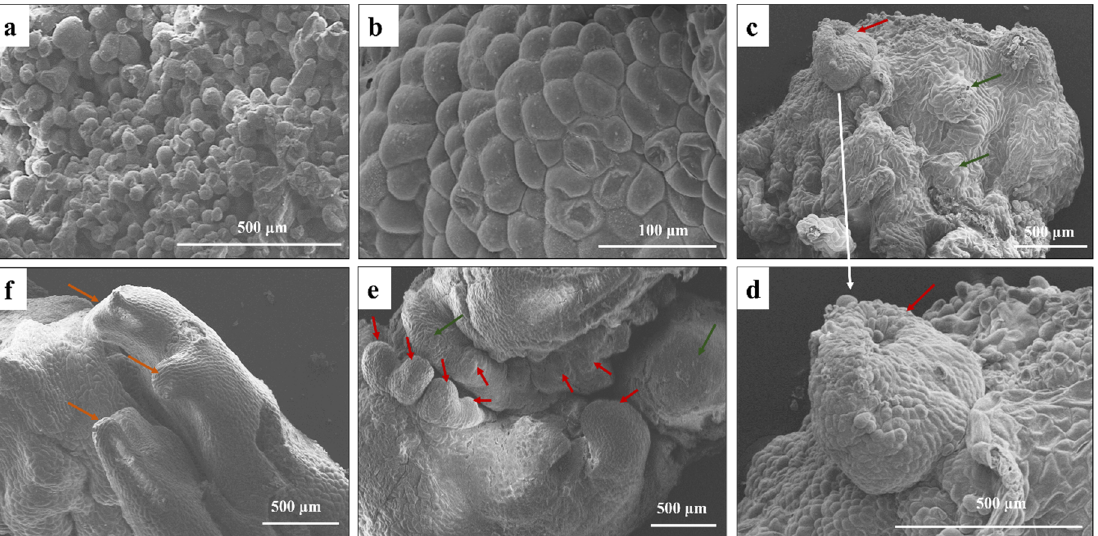
Figure 2. Scanning electron microscope (SEM) observation of shoot regeneration process. ( a ) Non- embryonic callus (S1), ( b ) Embryonic callus (S2), ( c – e ). Somatic embryos (S3) with established SAMs, ( f ) The regenerated shoots (S4). Green arrows indicated the established SAMs, red arrows marked somatic embryos, and yellow arrow means regenerated shoots.